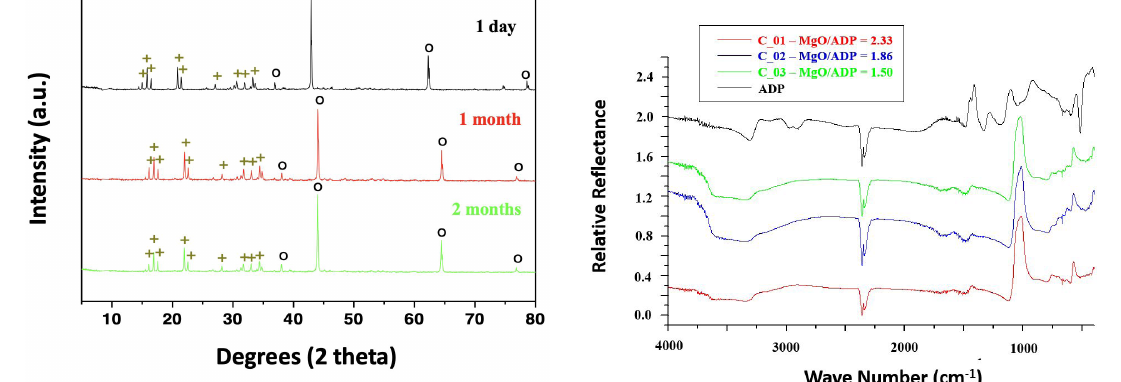
Figure 8. FTIR spectra of the lower region of the magnesium phosphate cements prepared from MgO powders calcined at